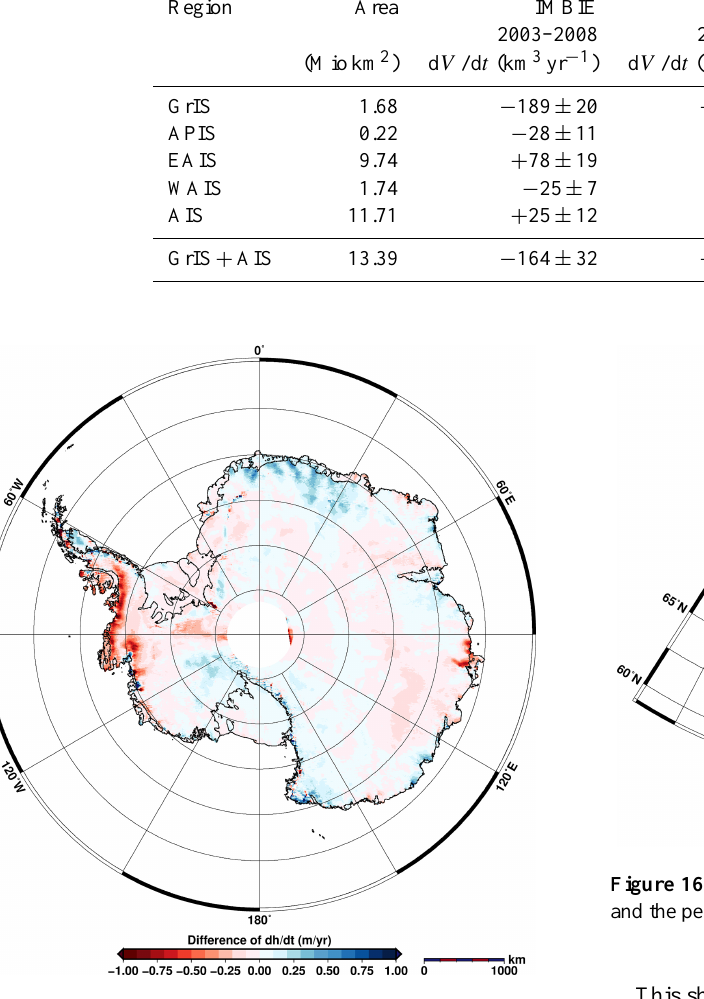
Figure 15. Difference of d h /d t between the period 2011 to 2014 and the period 2003 to 2009